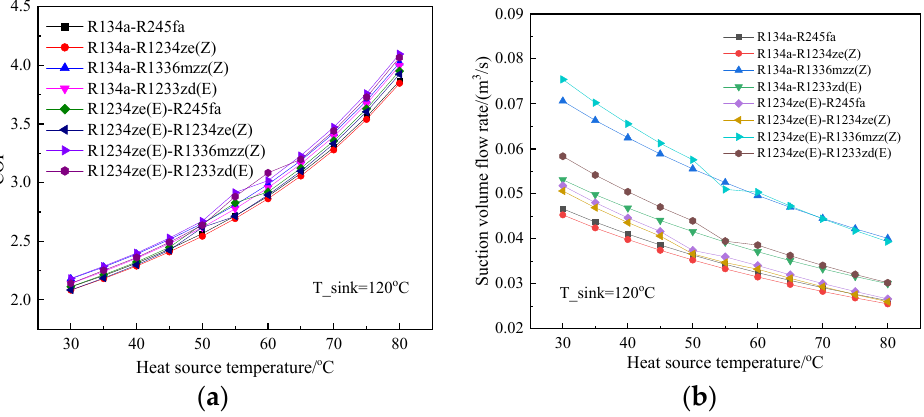
Figure 7. Effects of working fluids on the thermodynamic performance. ( a ) COP change with various working fluids. ( b ) Suction volume flow rate change with various working fluids.